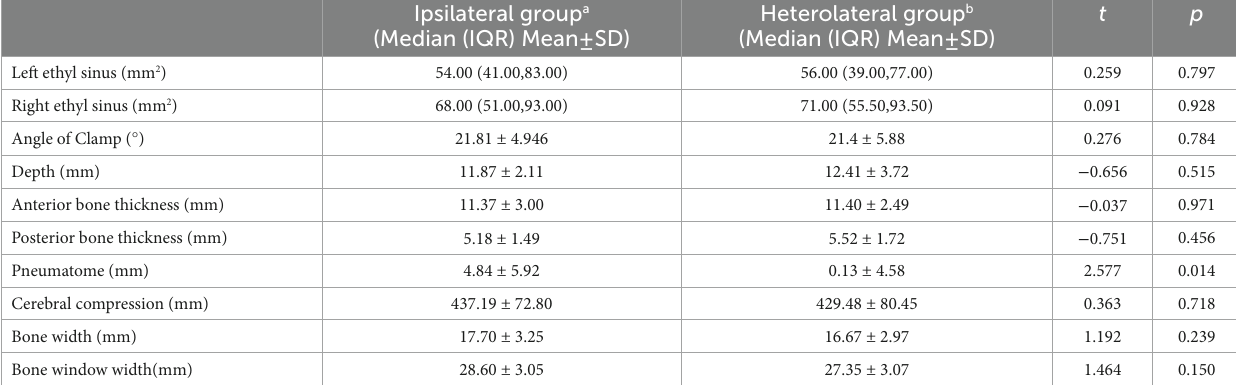
TABLE 4 Comparison of parameters between the ipsilateral group and heterolateral group in 60